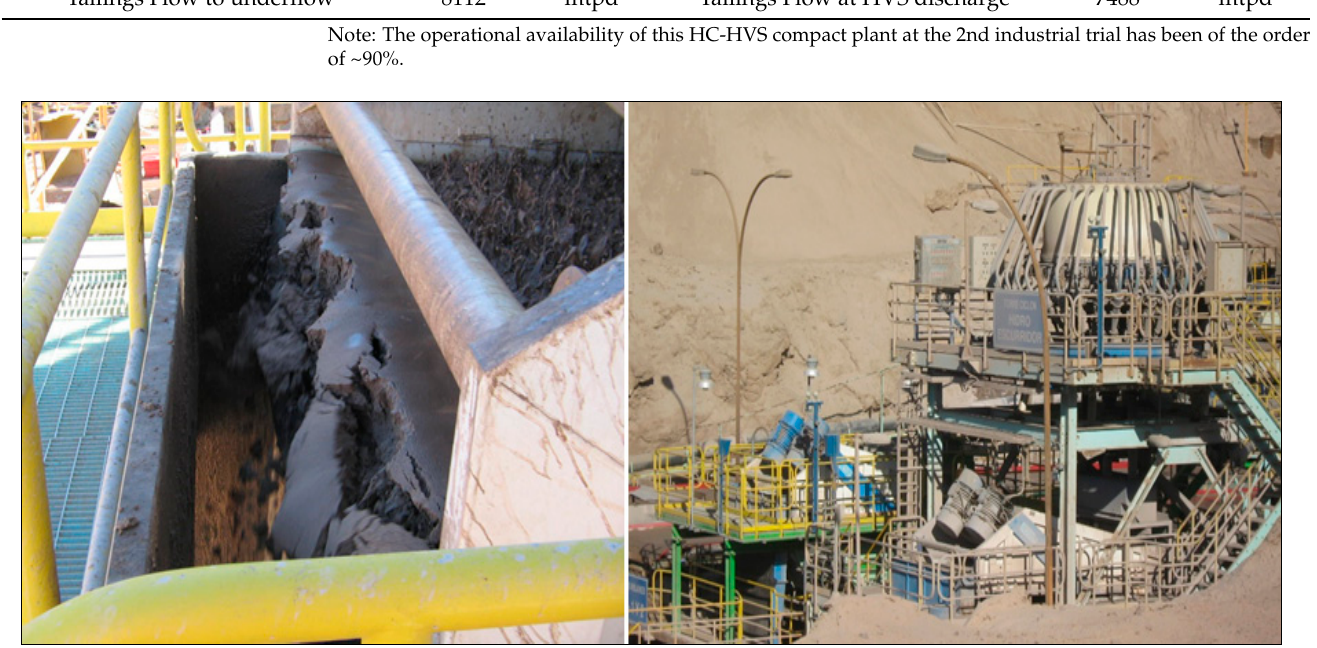
Figure 7. 2nd Industrial Trial Phase of Mantos Blancos Tailings Plant 8000 mtpd: Hydrocyclone Cluster + 02 Horizontal Vibratory Dewatering Screens [40,41].